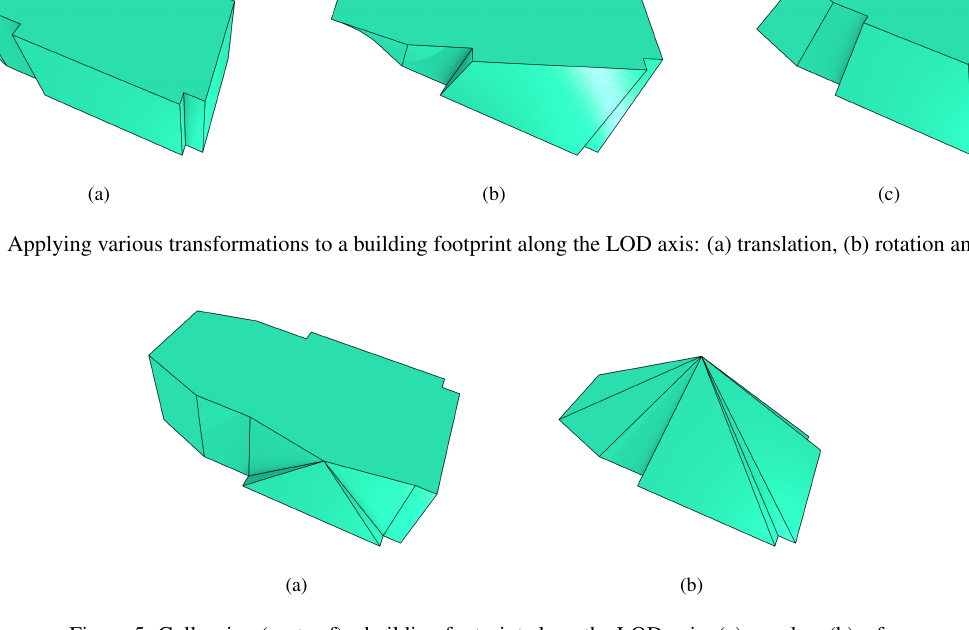
Figure 5: Collapsing (parts of) a building footprint along the LOD axis: (a) an edge, (b) a